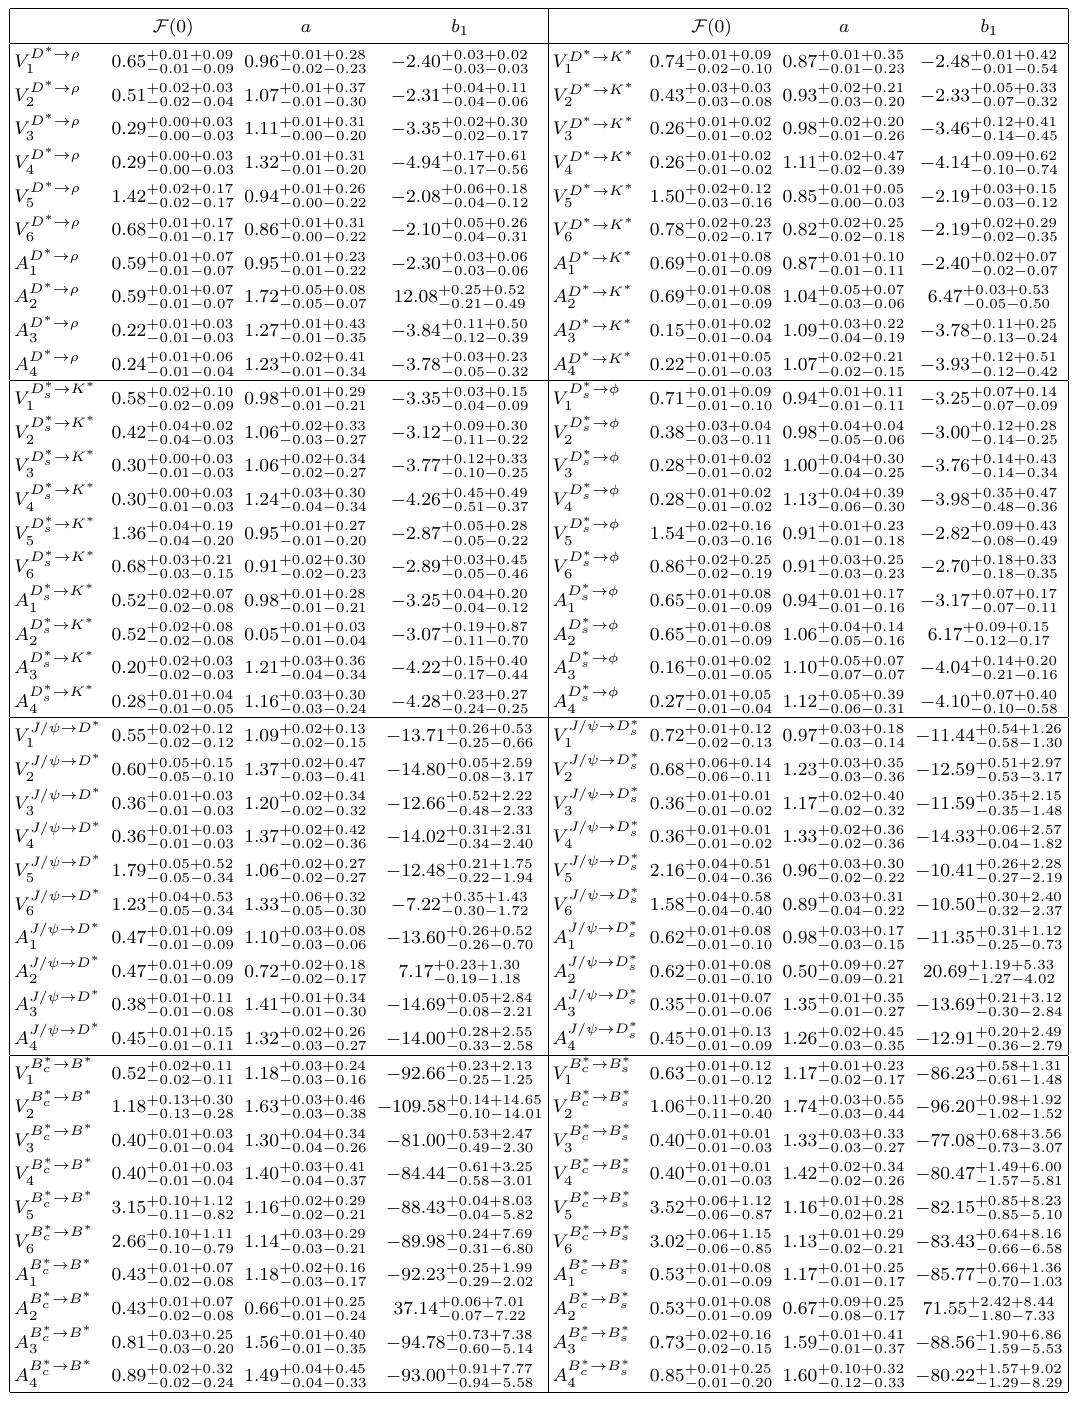
Table 4 . Fitting results for the form factors of c ! ( q; s ) induced D (cid:3) ! ( (cid:26) ; K (cid:3) ), D (cid:3)